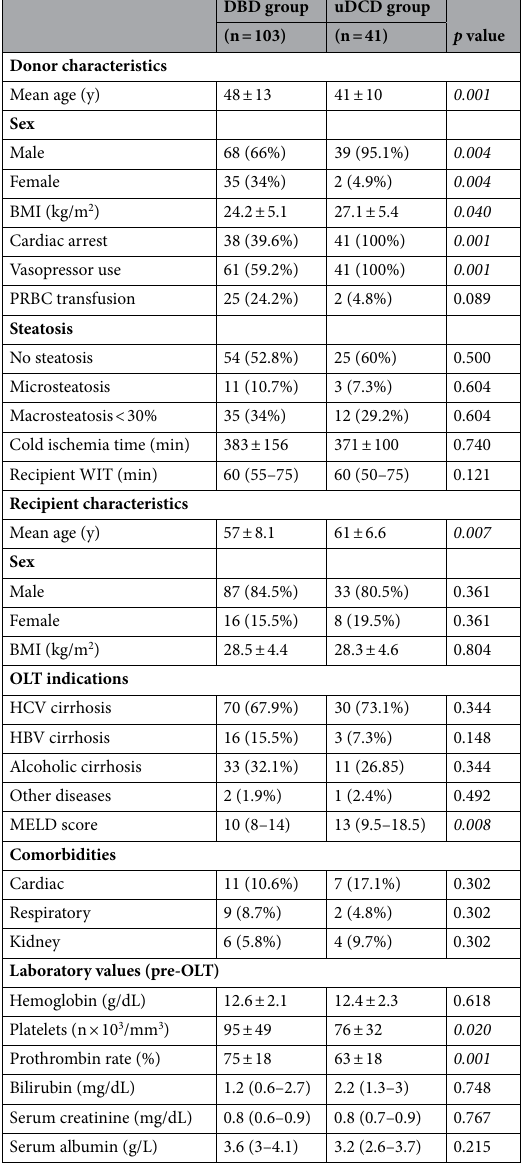
Table 1. Donor and pre-liver transplantation recipient characteristics. Italic values indicate statistically significant. AFP alpha-fetoprotein; BMI body mass index; DBD donation after brain death; HBV hepatitis B virus; HCV hepatitis C virus; MELD model for end stage liver disease; OLT orthotopic liver transplantation; PRBC packed red blood cells; uDCD uncontrolled donation after circulatory death; WIT warm ischemia